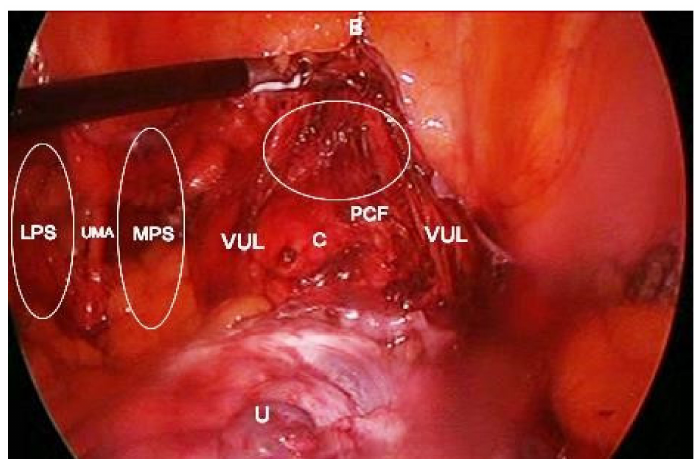
Figure 12. Development of vesicovaginal space during laparoscopic total hysterectomy shown in empty ellipse. The bladder is pulled up with a grasper. B—bladder; U—uterus; MPS—medial paravesical space; LPS—lateral paravesical space; C—cervix; UMA—umbilical artery; VUL—cranial portion of the vesico-uterine ligament; PCF—pubocervical fascia.